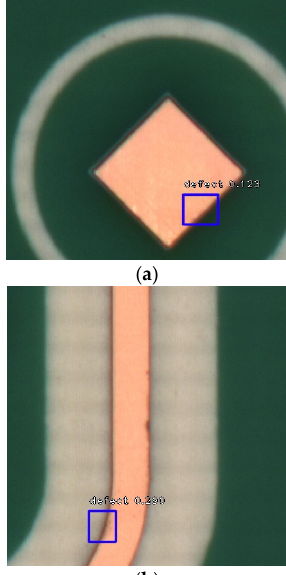
Figure 7. False positive PCB sections: ( a ) False positive PCB sample 1. ( b ) False positive PCB sample 2.